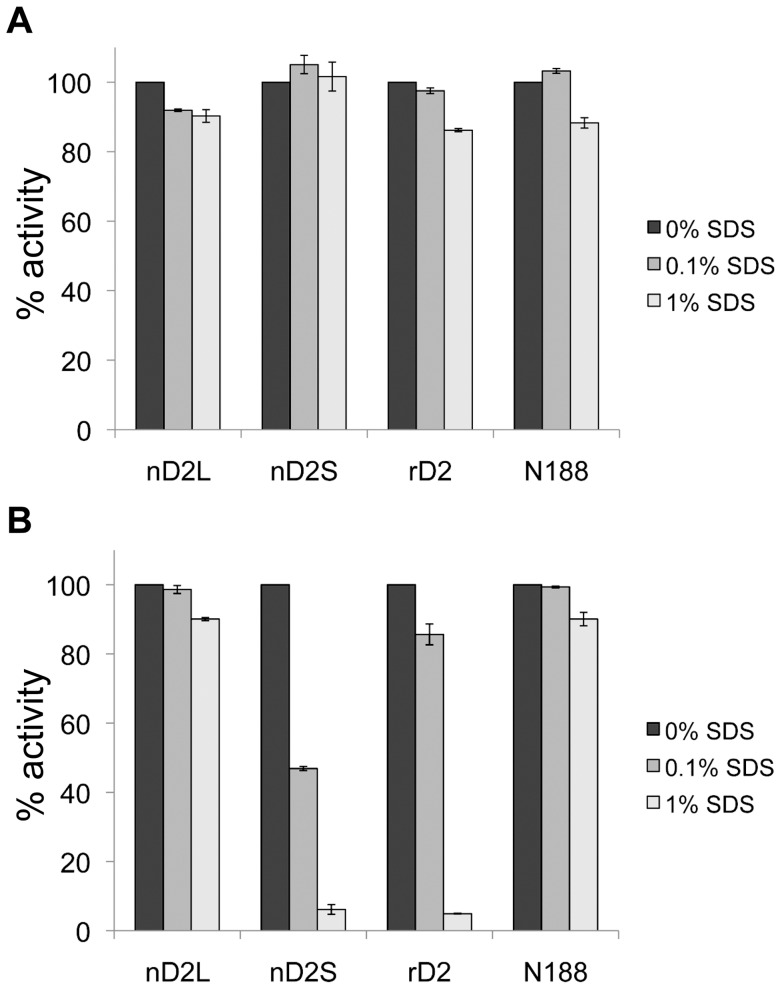
nD2L is resistant to deactivation by SDS at room temperature.Relative pNPG activity of D2 variants in the presence of SDS. (A) Enzymes assayed in the presence of SDS without the 1.5-h SDS pre-incubation prior to the assay. (B) Enzymes assayed after incubated in 1× Tris-glycine buffer with 0% (dark gray columns), 0.1% (gray columns) or 1% SDS (light gray columns) for 1.5 h at room temperature.